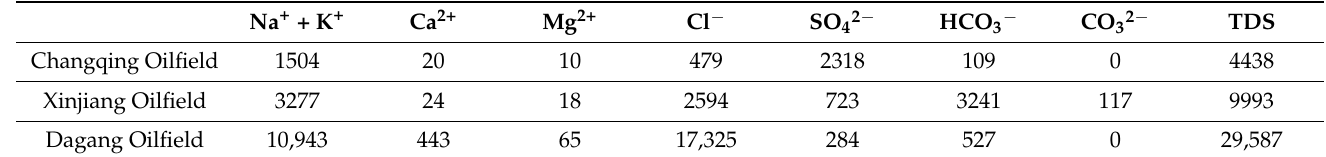
Table 1. Changqing simulated formation water formula